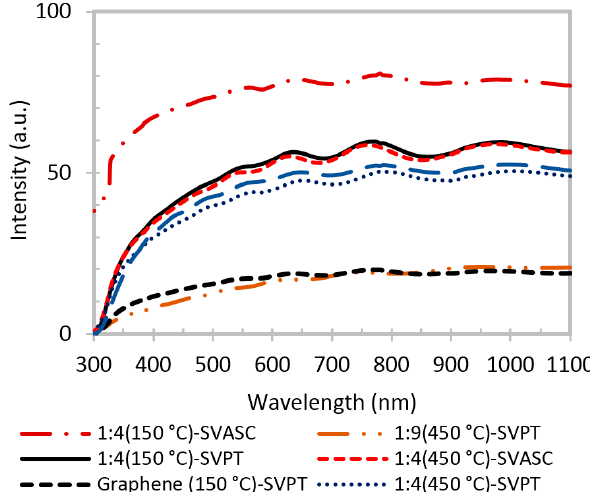
Figure 5. UV ‐ visible transmission of graphene and graphene ‐ TiO 2 thin films fabricated at various TiO 2 contents and annealing temperatures. The first number in the labels is the TS:GD volume ratio.